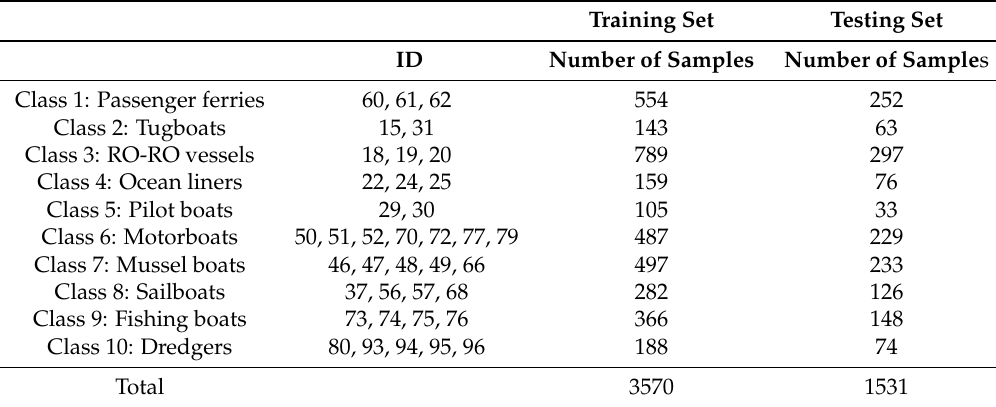
Table 1. Training set and testing set of classes of ship-radiated